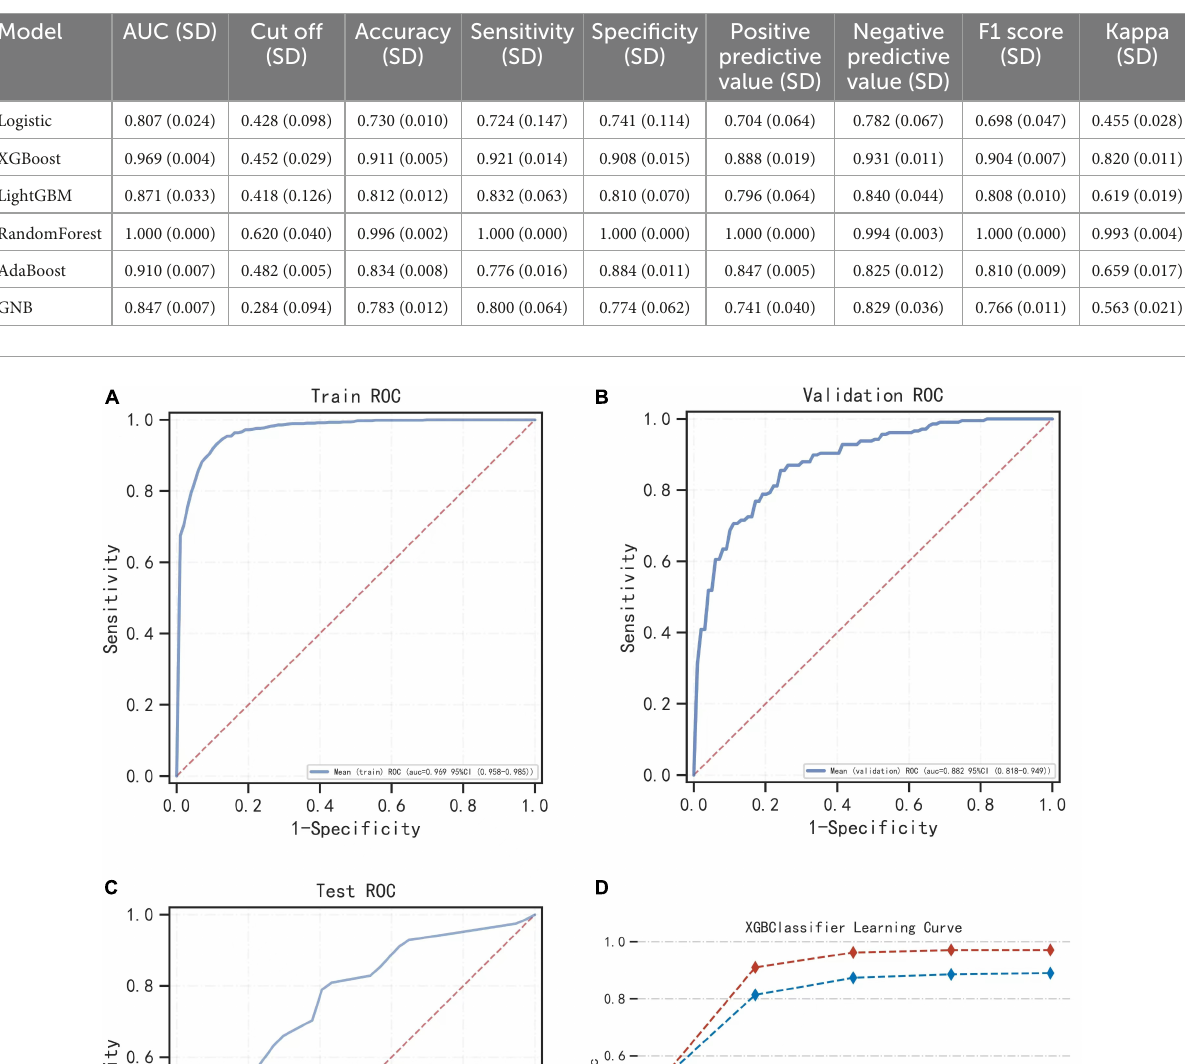
TABLE 2 Multi-model classification–training set results.